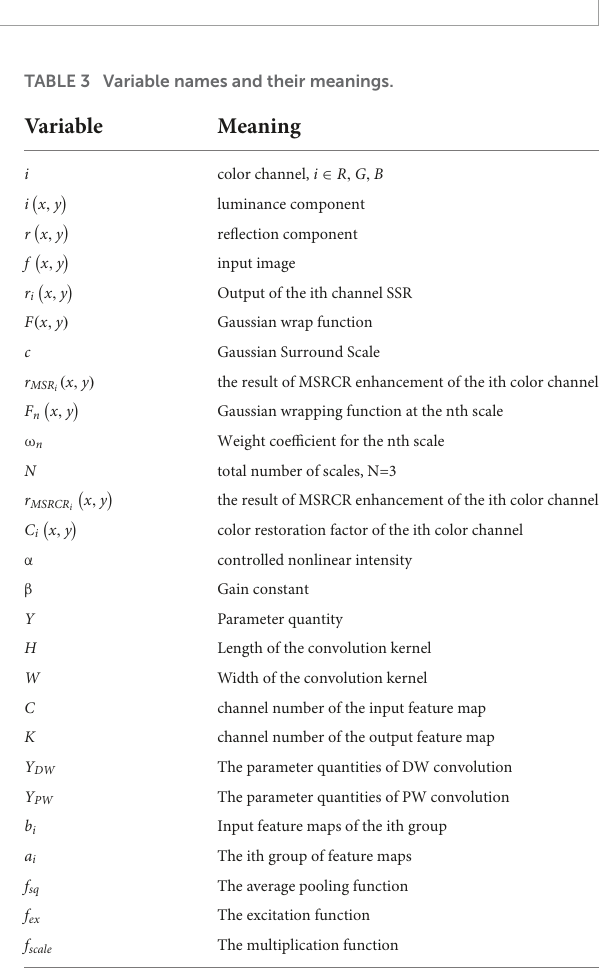
FIGURE1 Working principle diagram of the system.